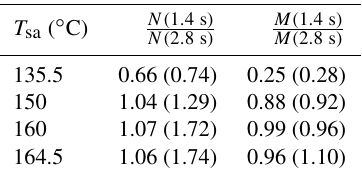
Table 3. The ratios of the simulated number concentrations and mass concentrations after the ejector diluter with the residence times of 1.4 and 2.8s, in measurement set 4. The values in parentheses de- note the measured values as presented in Table